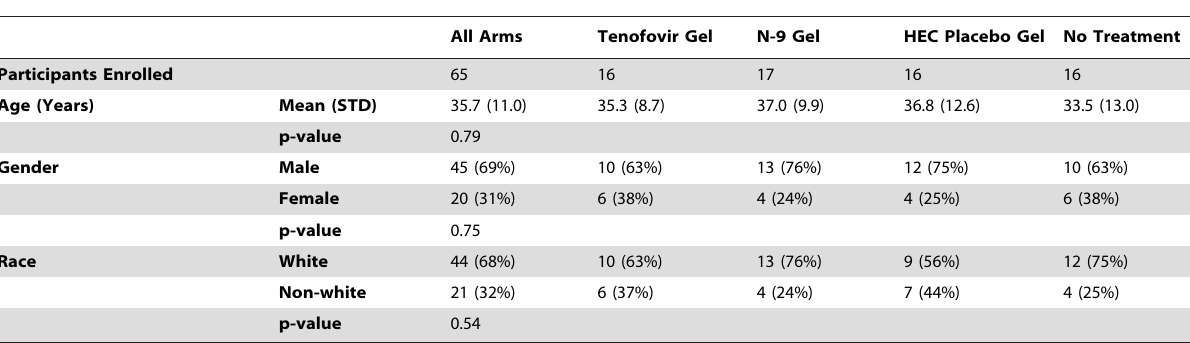
Table 1. Baseline demographics of each treatment group.